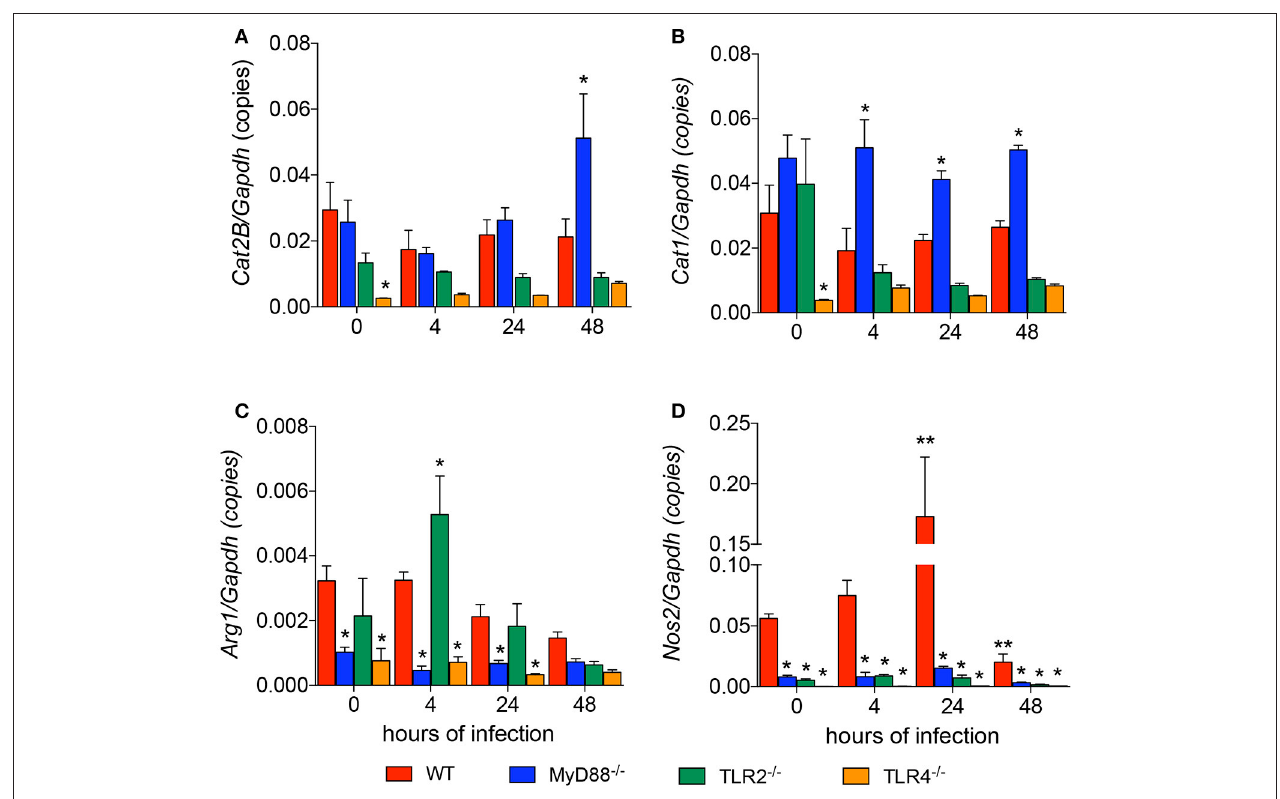
FIGURE 2 | Lack of TLR signaling leads to the differential expression of genes involved in polyamine and NO production. The BMDMs (5 × 10 6 ) from WT (red), MyD88 − / − (blue), TLR2 − / − (green), and TLR4 − / − (orange) mice were infected with L. amazonensis (MOI 5:1). Four, 24 and 48h after infection, the copy numbers of the Cat2B (A) , Cat1 (B) , Nos2 (C) , and Arg1 (D) mRNAs in these macrophages were quantified by RT-qPCR. Uninfected macrophages (0h) served as the control. Each bar represents the average ± SEM of the values obtained from three independent experiments ( n = 6–8). Statistical significance was determined